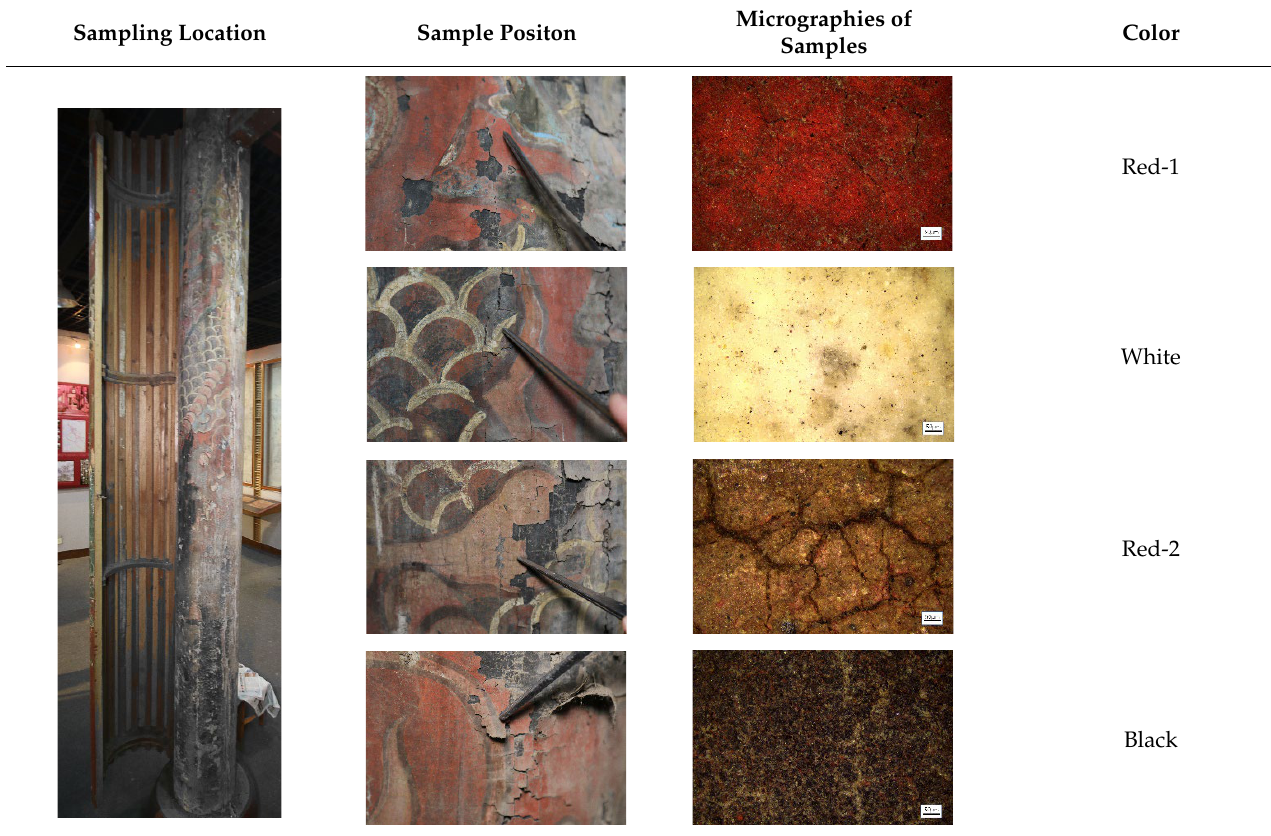
Table 1. The Taiping Heavenly Kingdom Palace sampling location.